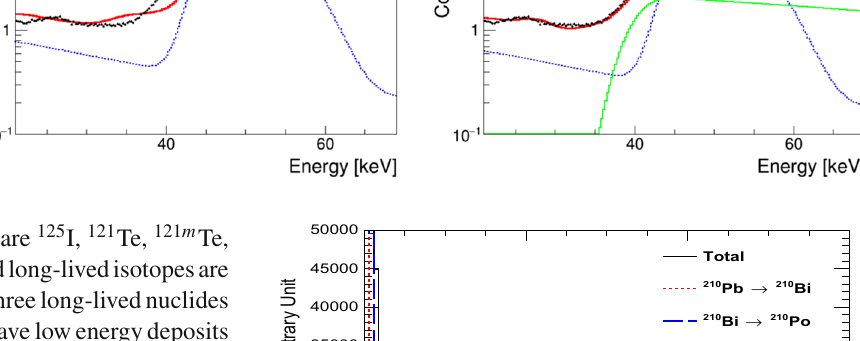
Fig. 3 Background modeling for low energy single hit events for Crystal 6. Background models not including 129 I (left) and including 129 I cosmogonic component (right) are shown. The solid green line corresponds to the 129 I isotope. The dashed blue line, the black dots, and the thick red line represent internal 210 Pb isotope, data, and the total MC, respectively